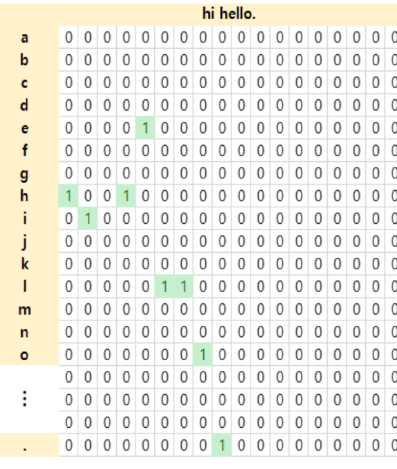
Figure 10. Example of one-hot encoding.